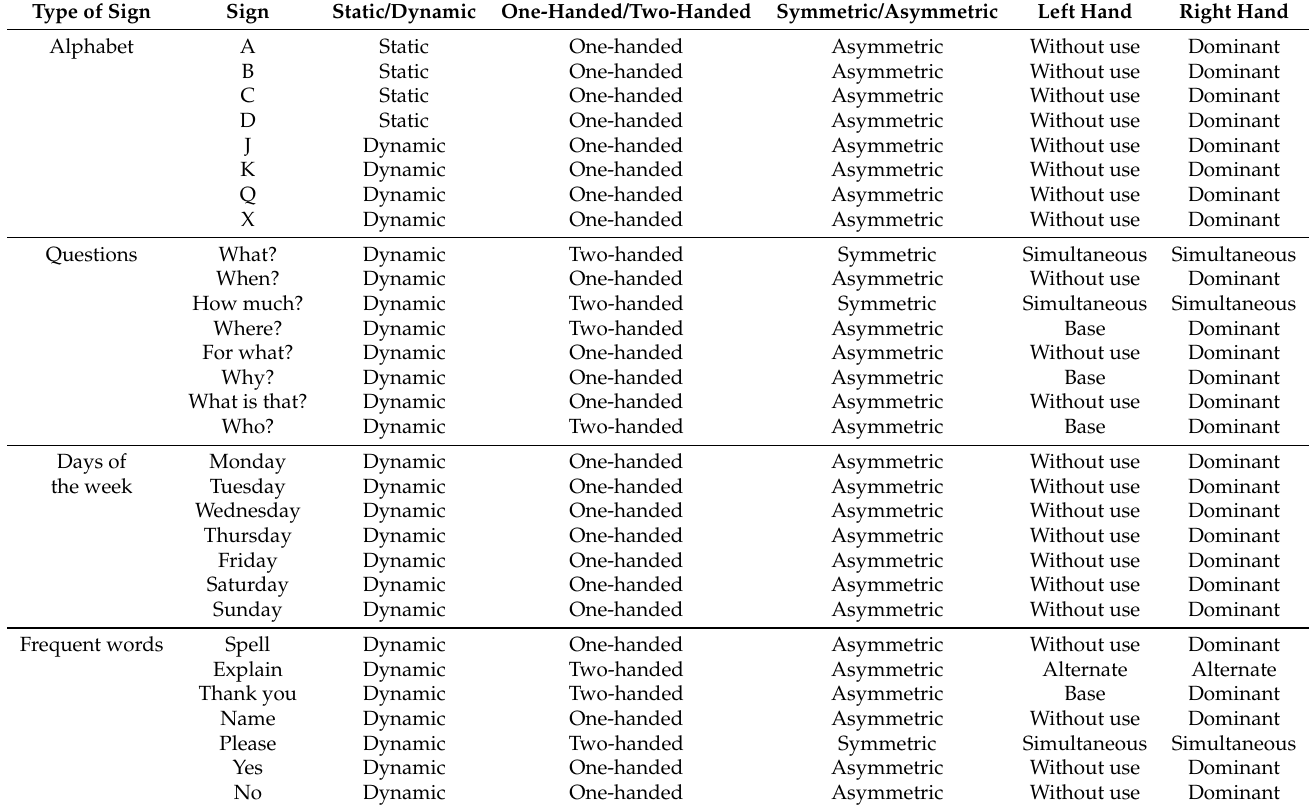
Table 2. Data corpus